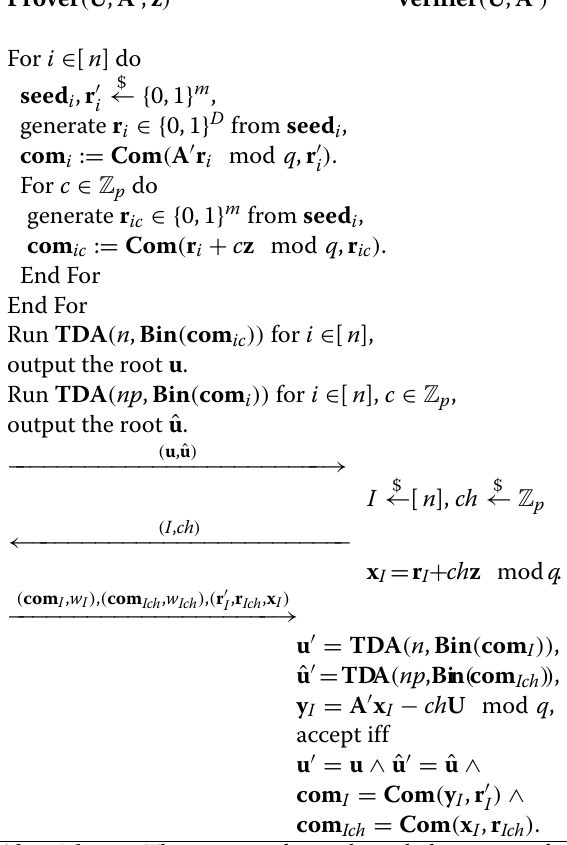
Algorithm 1: The improved zero knowledge